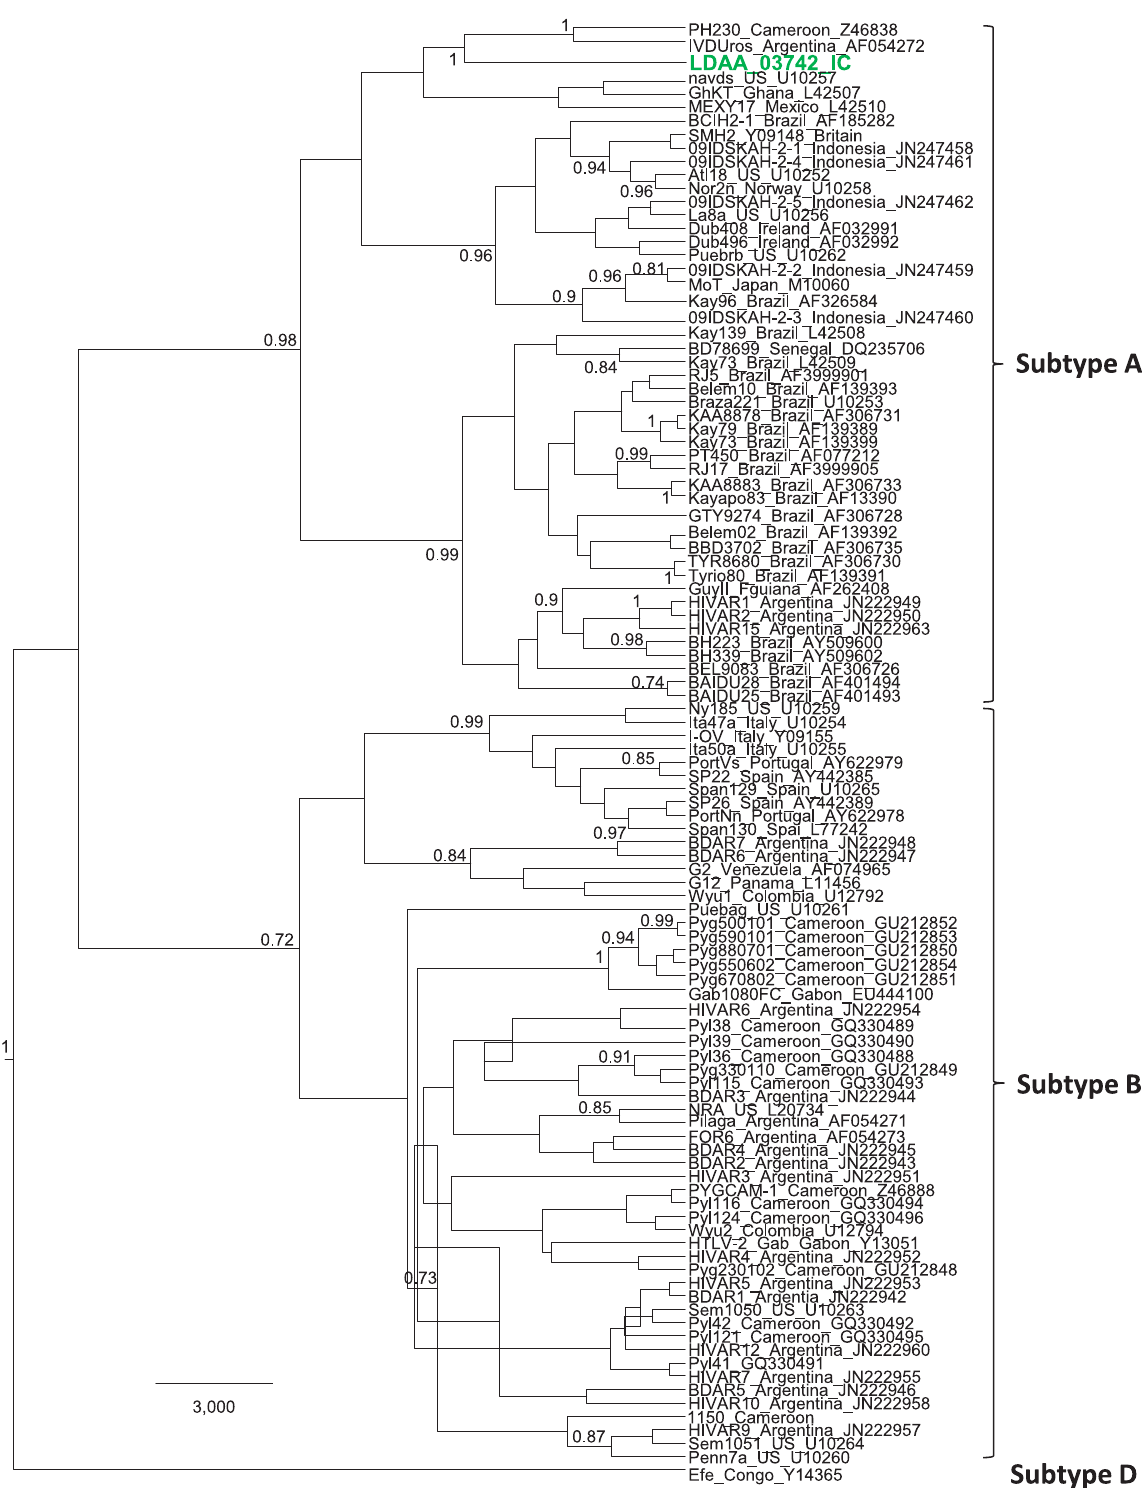
Fig 5. Evolutionary history of human T-lymphotropic virus type 2 (HTLV-2) in Côte d ’ Ivoire. Bayesian long terminal repeat (LTR) maximum clade credibility tree inferred using an alignment of 692 nucleotide positions and 105 global HTLV-2 taxa. The new Côte d ’ Ivoire HTLV-2 LTR sequence created in our study is shown in green text. Posterior probabilities > 0.7 are given at major nodes in the tree. Some subtype B taxa were inferred to have negative branch lengths indicative of a descendant node older than its direct ancestor, and is not present in the ancestral clade trees of the MCC tree. Scale bar is in units of time.